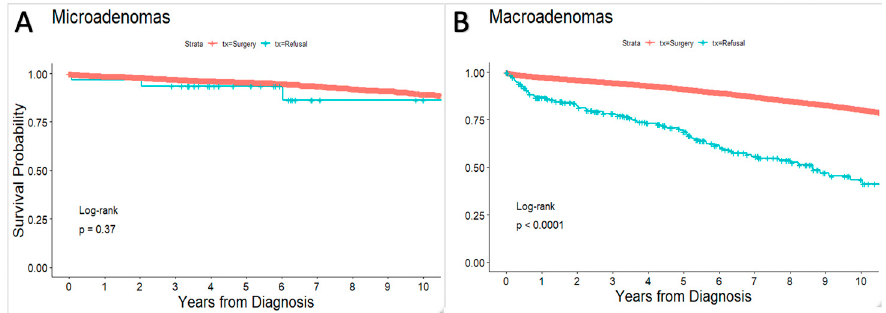
Figure 1. Kaplan–Meier curve of Overall Survival for Pituitary Adenoma Patients Matched on Age, C/D, and Tumor Size comparing Surgery Refusal and Surgery Receipt for ( A ) Microadenomas and ( B ) Macroadenomas.